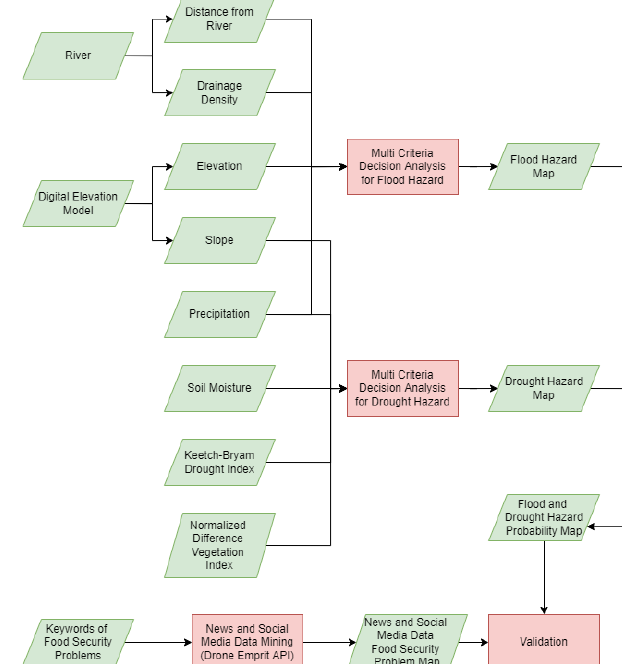
Figure 2 . General